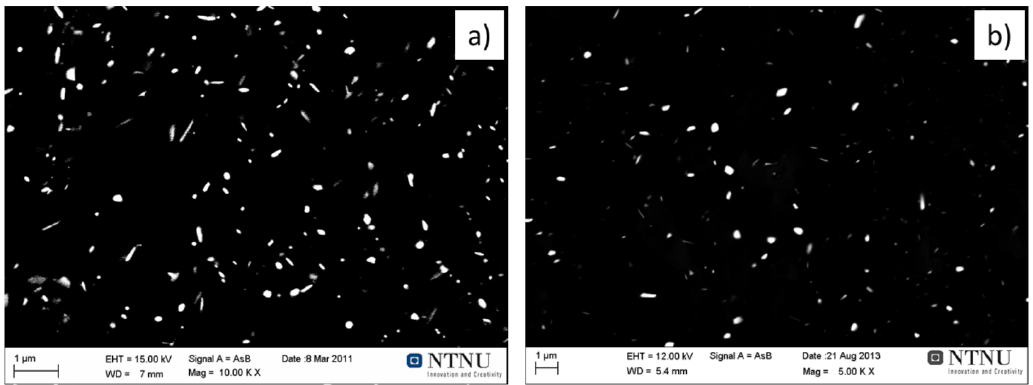
Table 2. The number density and mean diameter of dispersoids in materials in the as ‐ homogenized conditions.